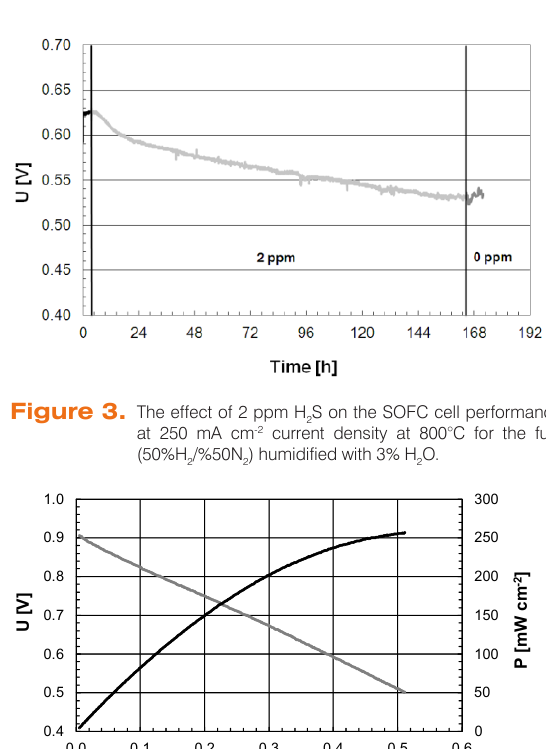
Figure 4. Cell voltage and power density of the tested anode- supported SOFC cell at